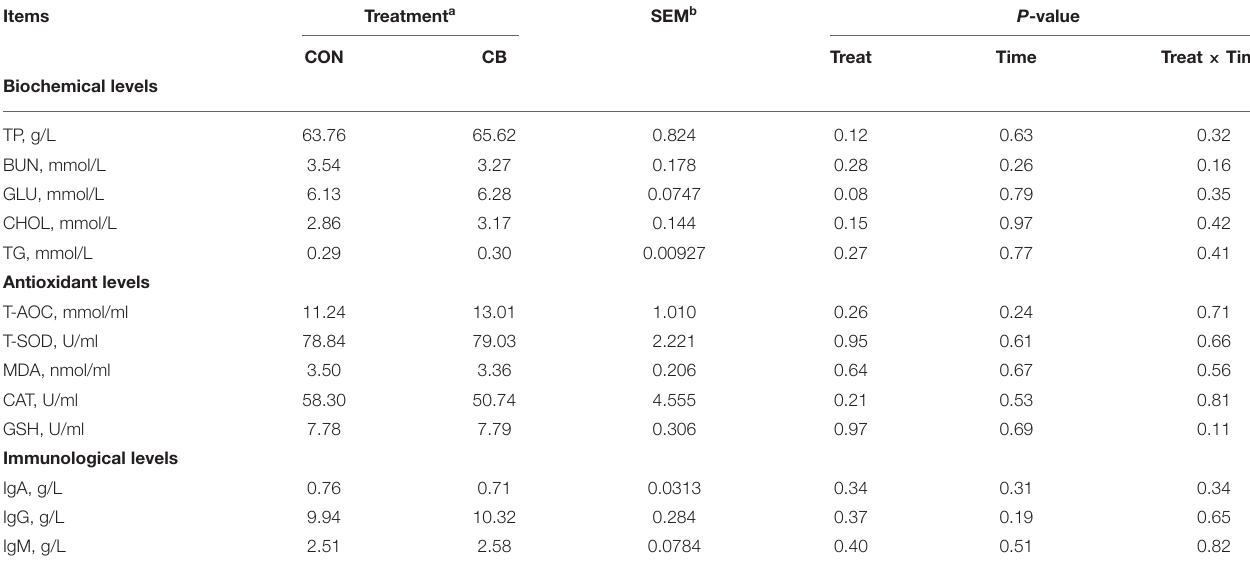
TABLE 4 | Effect of Clostridium butyricum on plasma parameters in